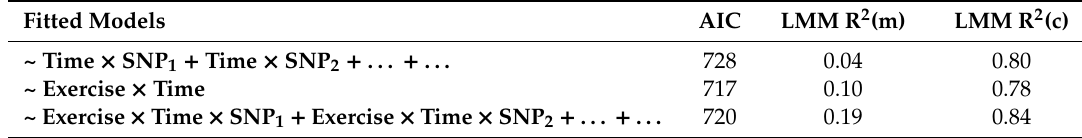
Table 2. R squared (marginal and conditional, i.e., for fixed e ff ects only and combined fixed e ff ects and random intercept) and Akaike Information Criteria (AIC) for the models with and without Exercise (YES / NO), time (post-motor practice and seven-day retention) and the identified SNPs. Smaller AIC values reflect a better goodness of fit. AIC values are derived from models fit using maximum likelihood (ML). A larger marginal R-squared (R 2 (m)) reflects a higher proportion of accounted variance from the fixed factors alone, whereas a larger conditional R-squared (R 2 (c)) indicates a higher proportion of variance explained by both fixed and random factors. Fitted Models